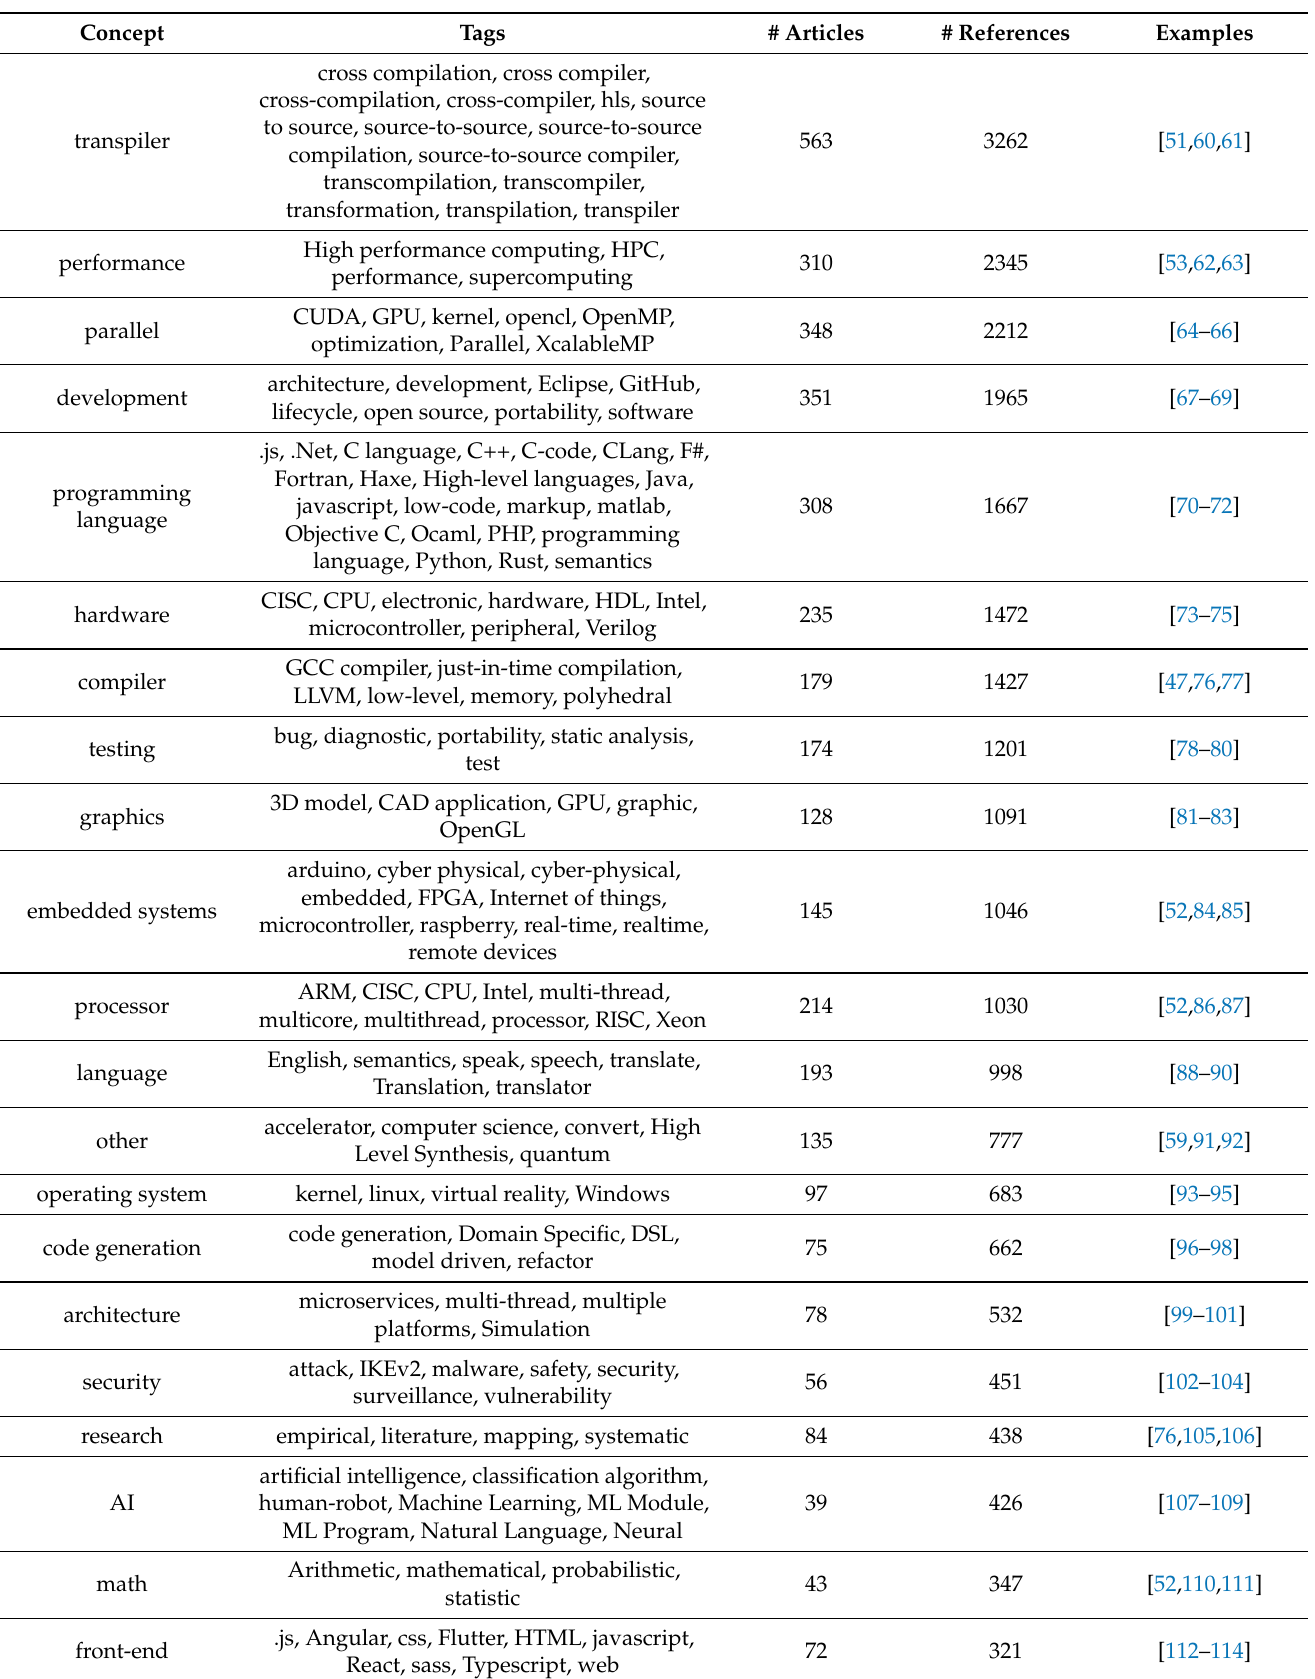
Table 14. Comprehensive mapping